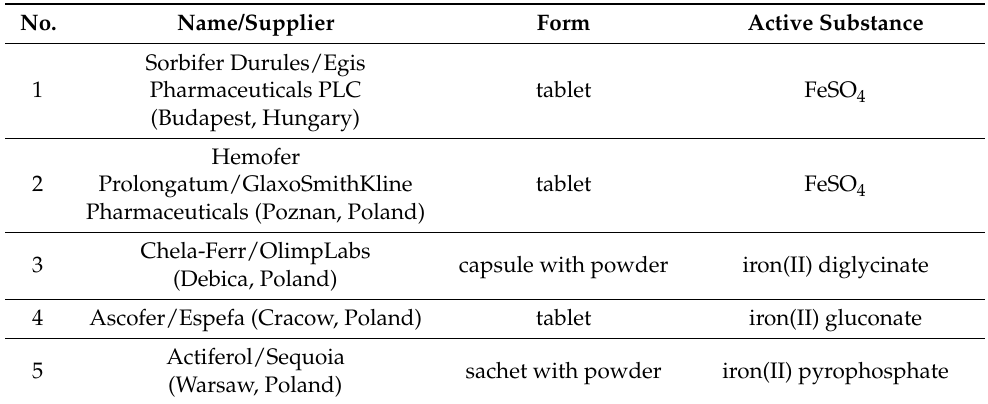
Table 4. Pharmaceutical formulations used for validation of developed